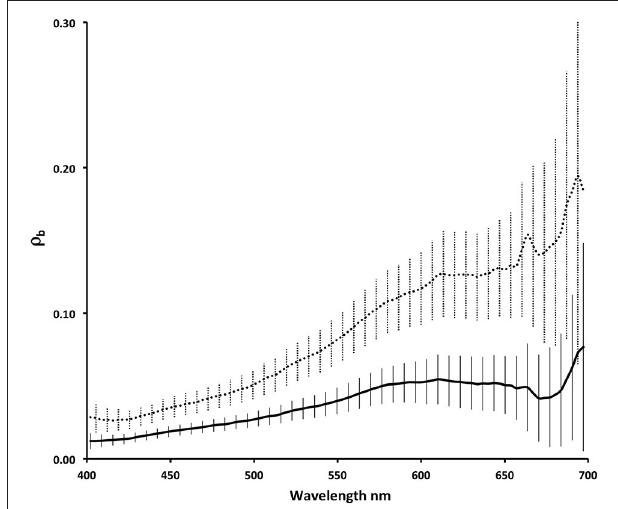
FIGURE 9 | Mean benthic reflectance of coral (solid curve) and uncolonized sediment (dotted curve) within the coconut patch reef computed using Equation (5), where D < 5m. Data were parsed based on manual interpretation of in-water imagery (GP1 camera). Vertical bars indicated ± 1 standard deviation relative to the mean.